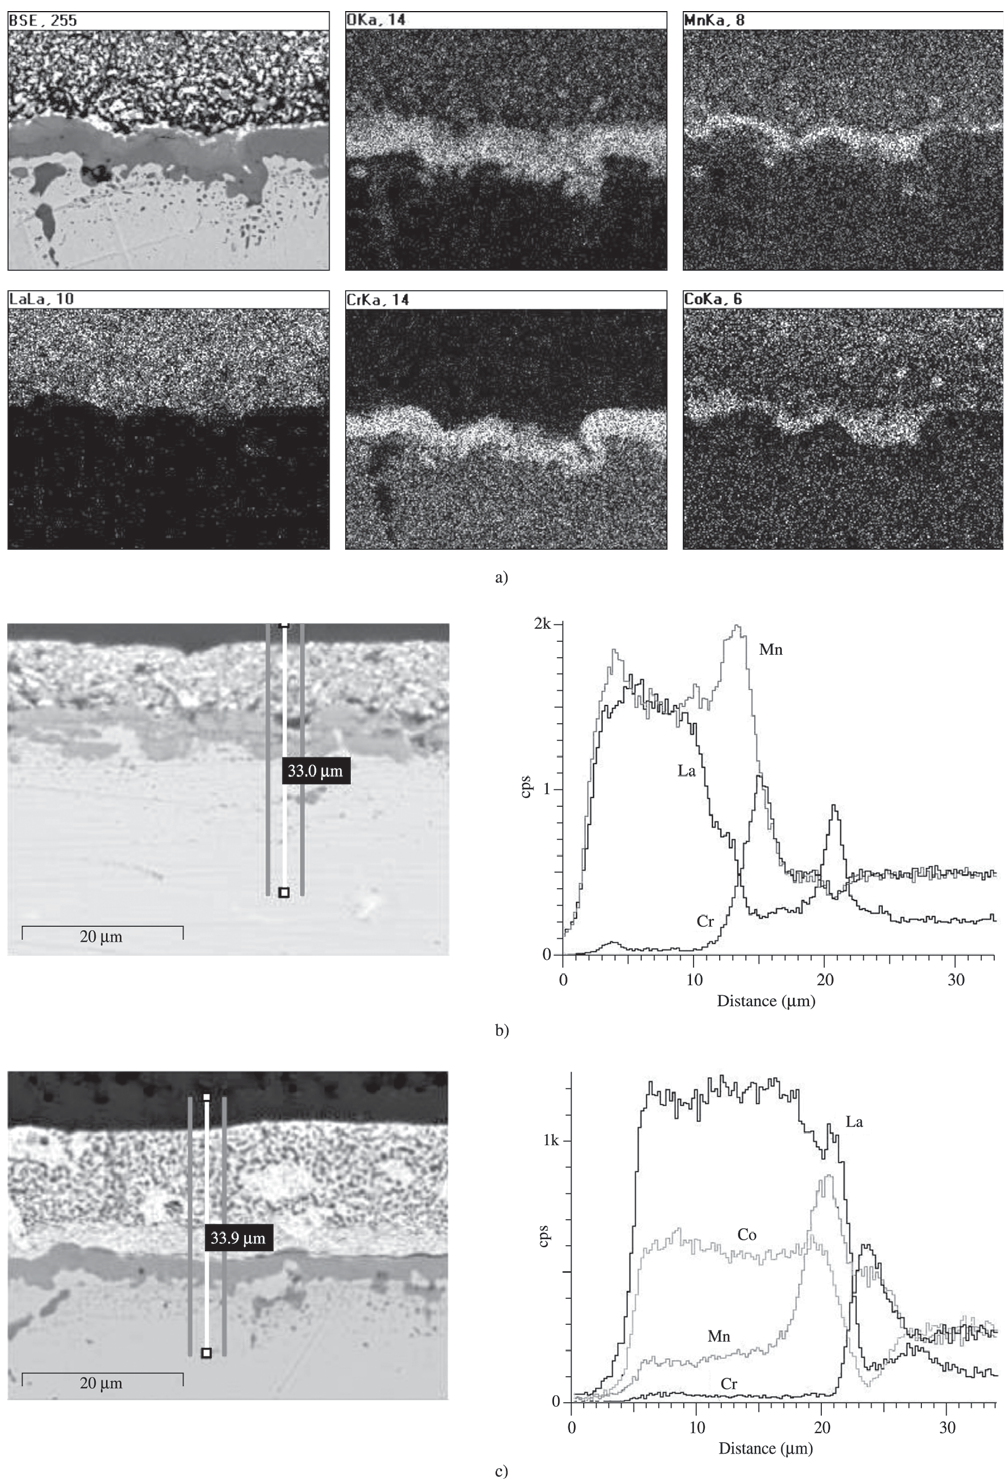
Figure 6. Interface layer formed between ferritic steel of type JS-1 (batch HMZ) with a) LaCoMnO layer during 1000 h exposure at 800 °C in air, showing metallographic cross section, element mappings and EDX line